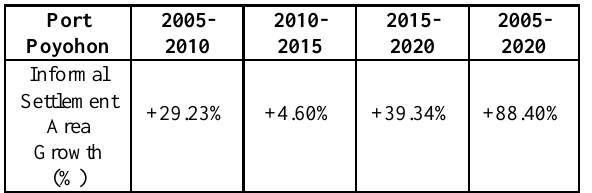
Table 6. Informal Settlement Growth in Percentage in Brgy. Port Poyohon